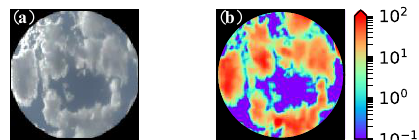
Figure B1. Examples of ( a ) an input true-color image and ( b ) estimated SCOT. The sun is located outside of the image in the upper left direction, with solar zenith and azimuth angles of 69.7° and 195.5°, respectively. In this image, the azimuth is defined to be positive in the clockwise direction from the right.